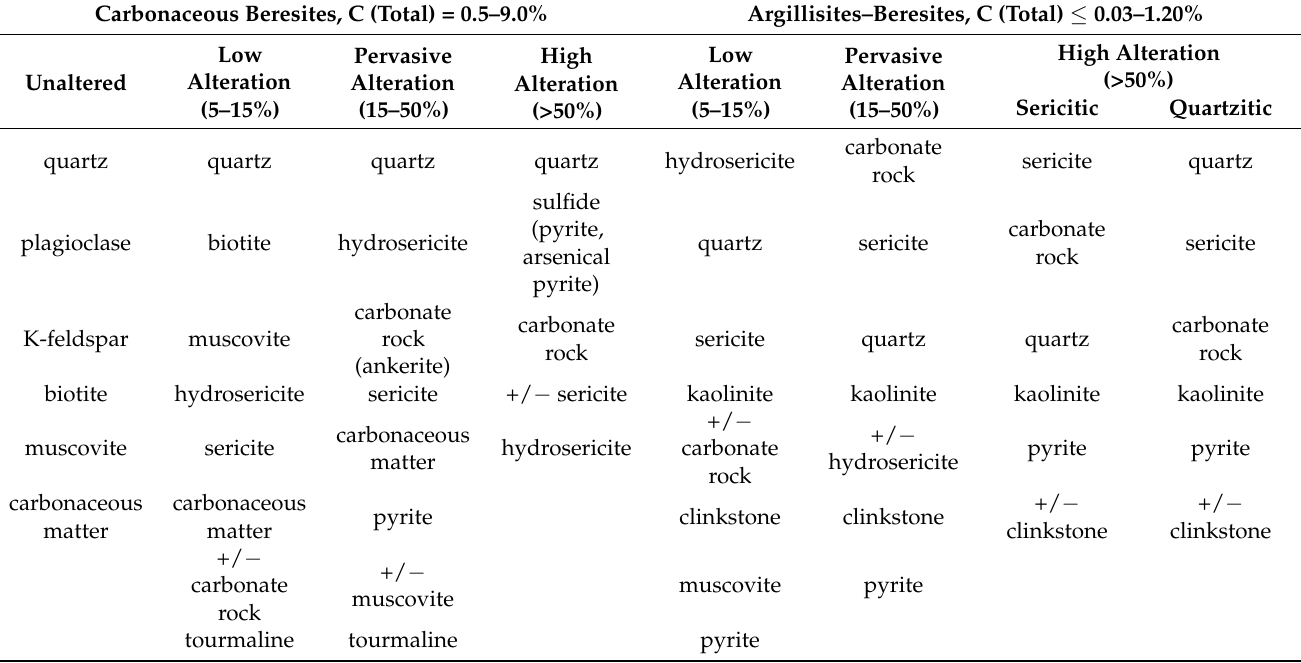
Table 2. Average compositions of waste rock, minerals are listed in descending